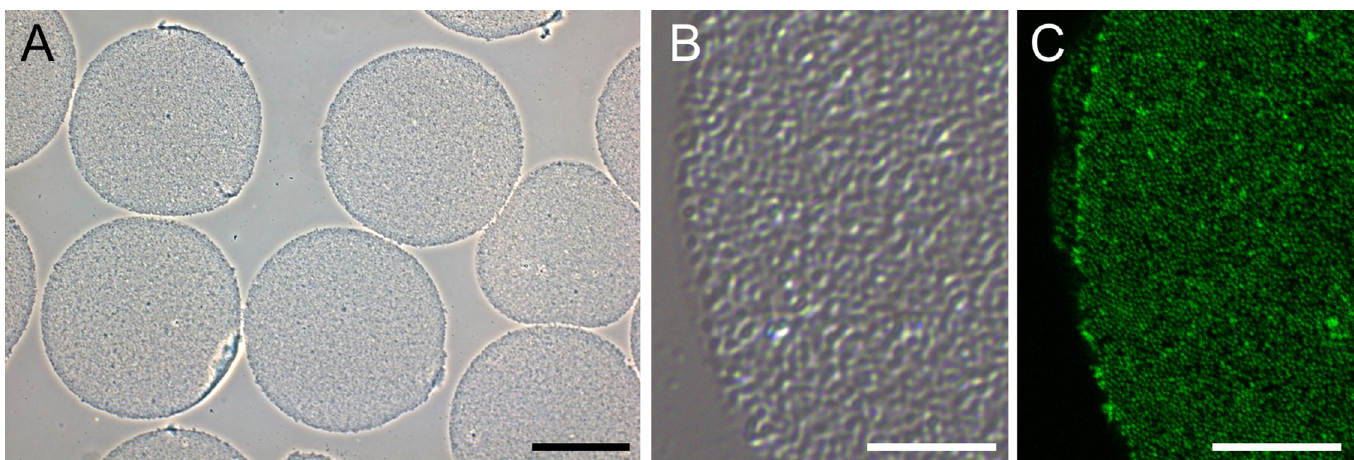
Fig 1. Isolated cortices from unfertilized eggs. (A) Phase contrast image of isolated cortices attached to poly-L-lysine treated coverslip. (B) DIC image of cortex at high magnification. Granular pattern indicates multiple cortical granules. (C) Confocal image of actin staining. There is small punctate pattern of actin staining, which is typical for egg cortices. Scale bars 50 μ m (A), 10 μ m (B, C). (mean) ± 0.12 (SD)% of input) from cortices. Percentage of purified poly(A) RNA from iso- lated cortices was 2.27(mean) ± 0.34(SD) times lower than that from eggs.